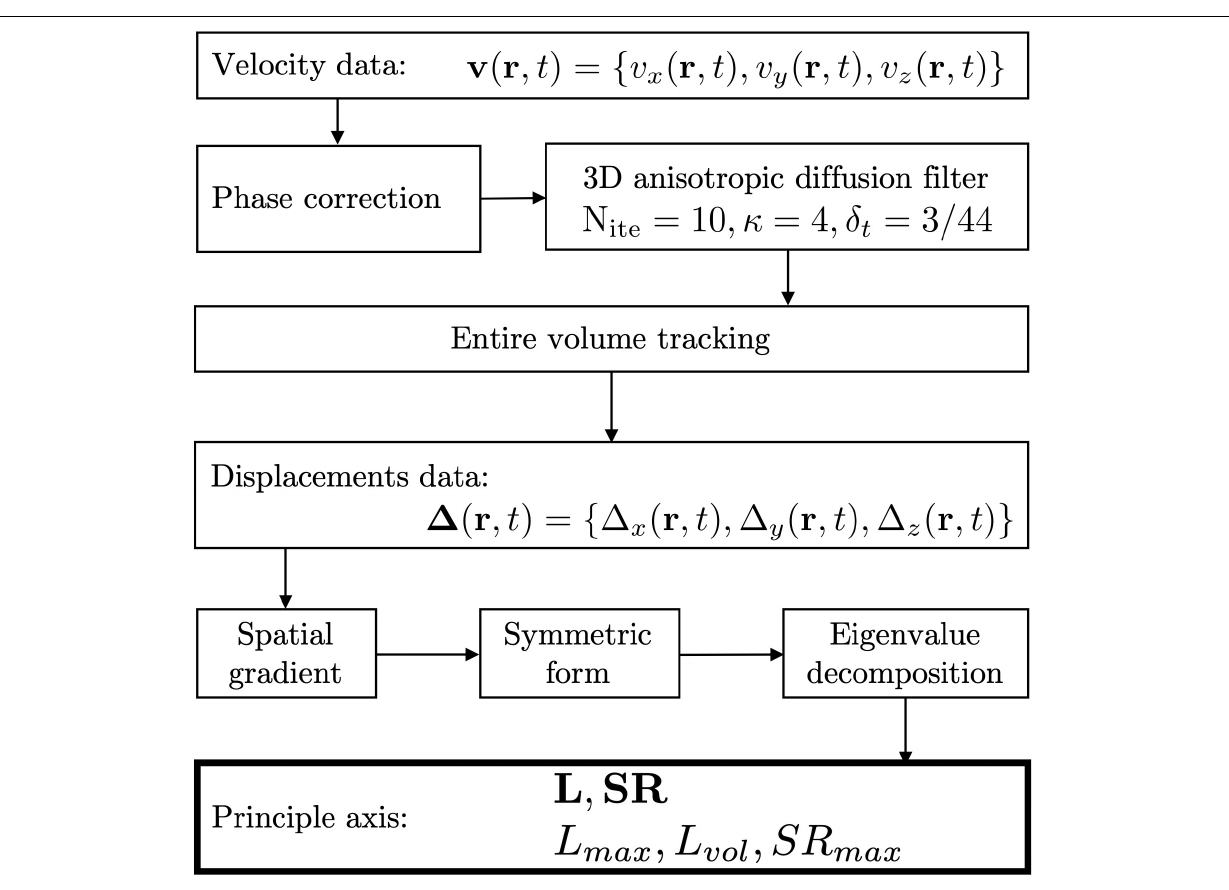
FIGURE 2 | Flowchart of the image processing pipeline to estimate strain and strain rate indices. Velocity data is corrected for phase shading artifacts and denoised with a 3D anisotropic diffusion filter. Each voxel is tracked through the temporal cycle to obtain displacement maps. Spatial gradients of velocity and displacement lead to strain and strain rate maps, respectively. Lagrangian strains L were calculated as were the strain rates, SR . In addition to the eigenvalues of the tensors, two invariants were computed from the strain tensor: volumetric ( L vol ) and maximum shear strain ( L max ) and one invariant for the shear strain rate: maximum shear strain rate: SR max